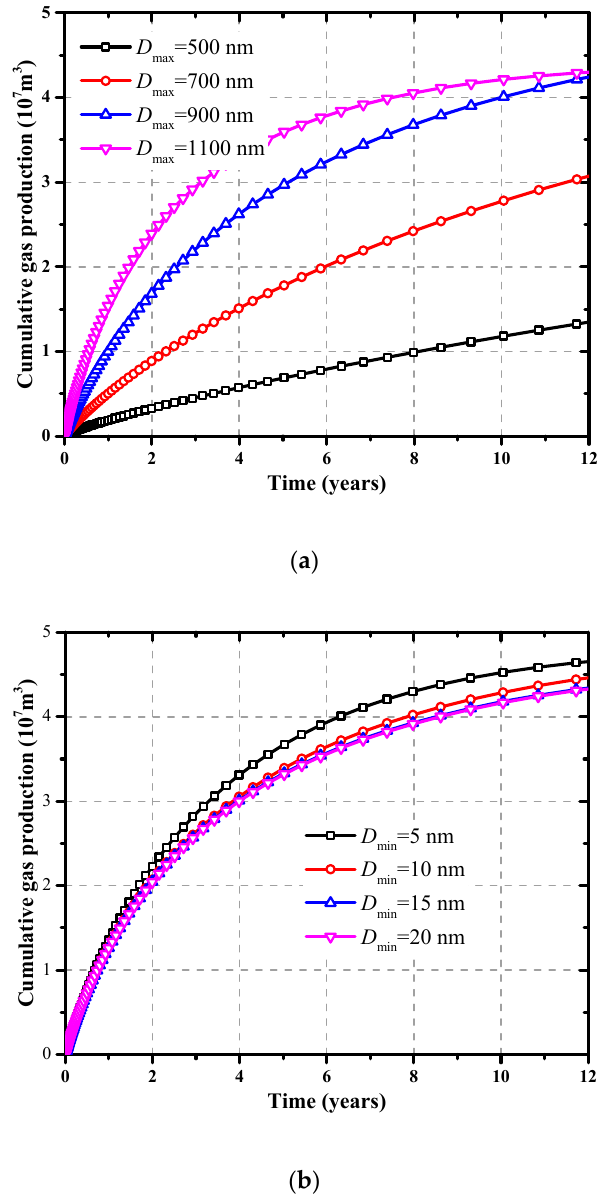
Figure 10. E ff ects of extreme pore diameters on cumulative gas production: ( a ) maximum pore diameter D max ; ( b ) minimum pore diameter D min .